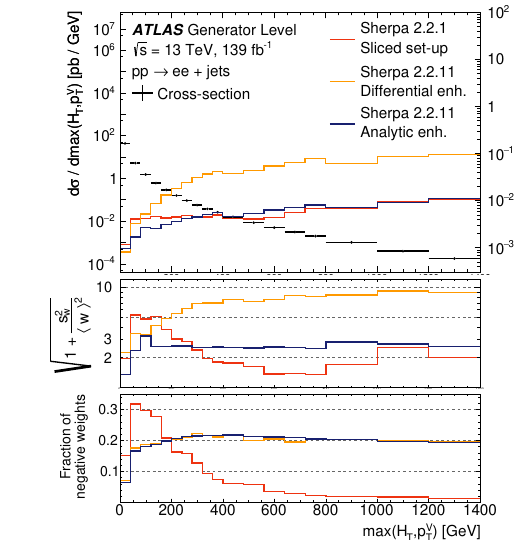
(b) pp → e + e − + jets as function of max ( H , p V ) . T T and (b) T and max ( H ) . , p V T T T